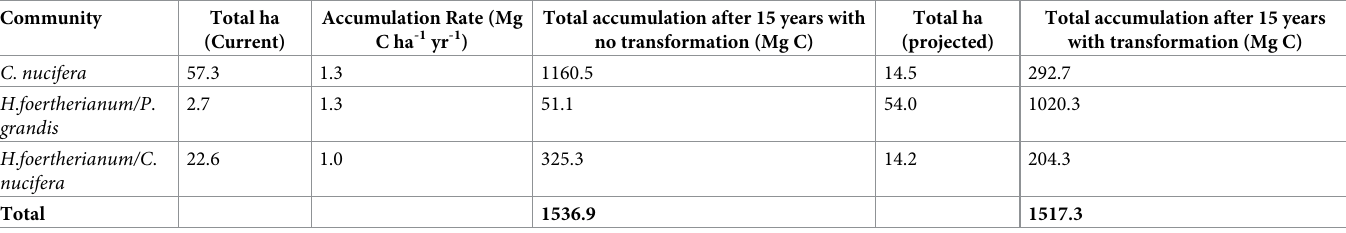
Table 6. Calculations of soil carbon accumulation estimates in transformation and no transformation scenarios based on changes to community structure.